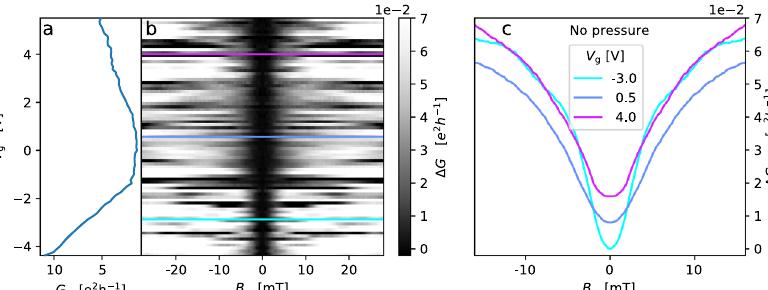
Fig. 3 Weak localization measurement at ambient pressure. a Zero- fi eld conductance G ( V g , B = 0), used to extract D and τ ia , as detailed in the text. b 2D grayscale plot of the two-terminal conductance corrected by the zero- fi eld conductance Δ G ( V g , B ) = G ( V g , B ) − G ( V g , B = 0). c Two-terminal magnetoconductance at fi xed gate voltages marked in b with ±1.5 V averaging along the vertical axis to reduce the effect of UCF. The curves are shifted by 0.01 e 2 /h for clarity. At small magnetic fi elds ( B < 5 mT), the well-formed conductance dip corresponds to weak localization (WL) effect that is present at all gate voltages, although the curve shape changes slightly. At higher fi elds ( B > 5 mT), the in fl uence of UCF leads to irregular line shapes and were not analyzed in the current